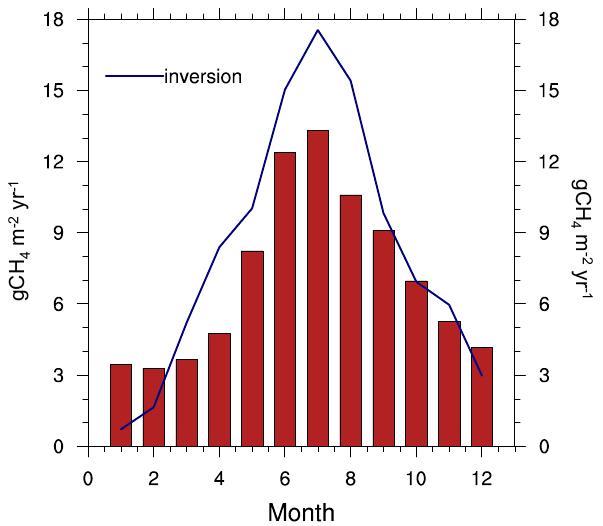
Fig. 9. Sum of monthly CH 4 emissions in the West Siberian Low- lands: bar chart represents 30-yr mean at present day; solid line shows results from an data-driven inversion study for the year 2009 (Winderlich, 2011).